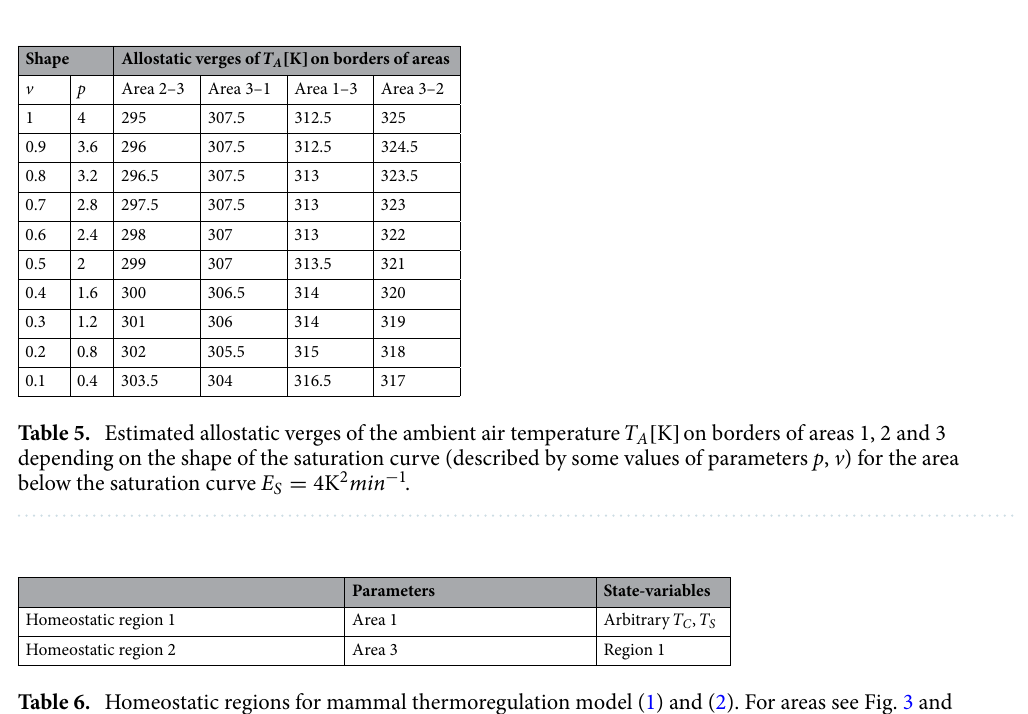
Table 6. Homeostatic regions for mammal thermoregulation model (1) and (2). For areas see Fig. 3 and Tables 4 and 5. For regions see Fig. 2.